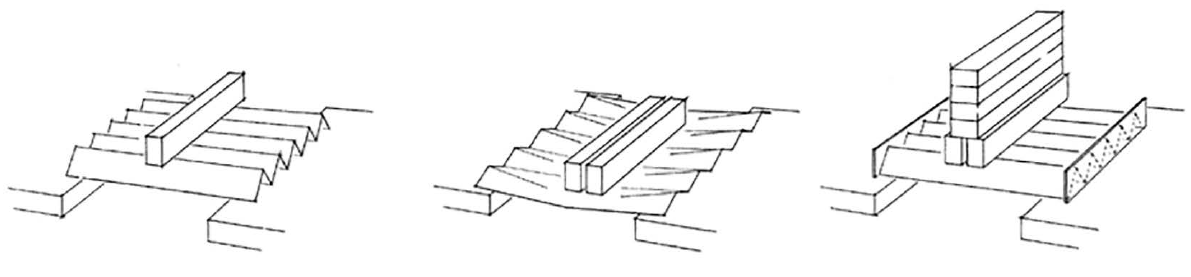
Figure 1: Constraining the edges of folded surfaces increases their stability and load carrying